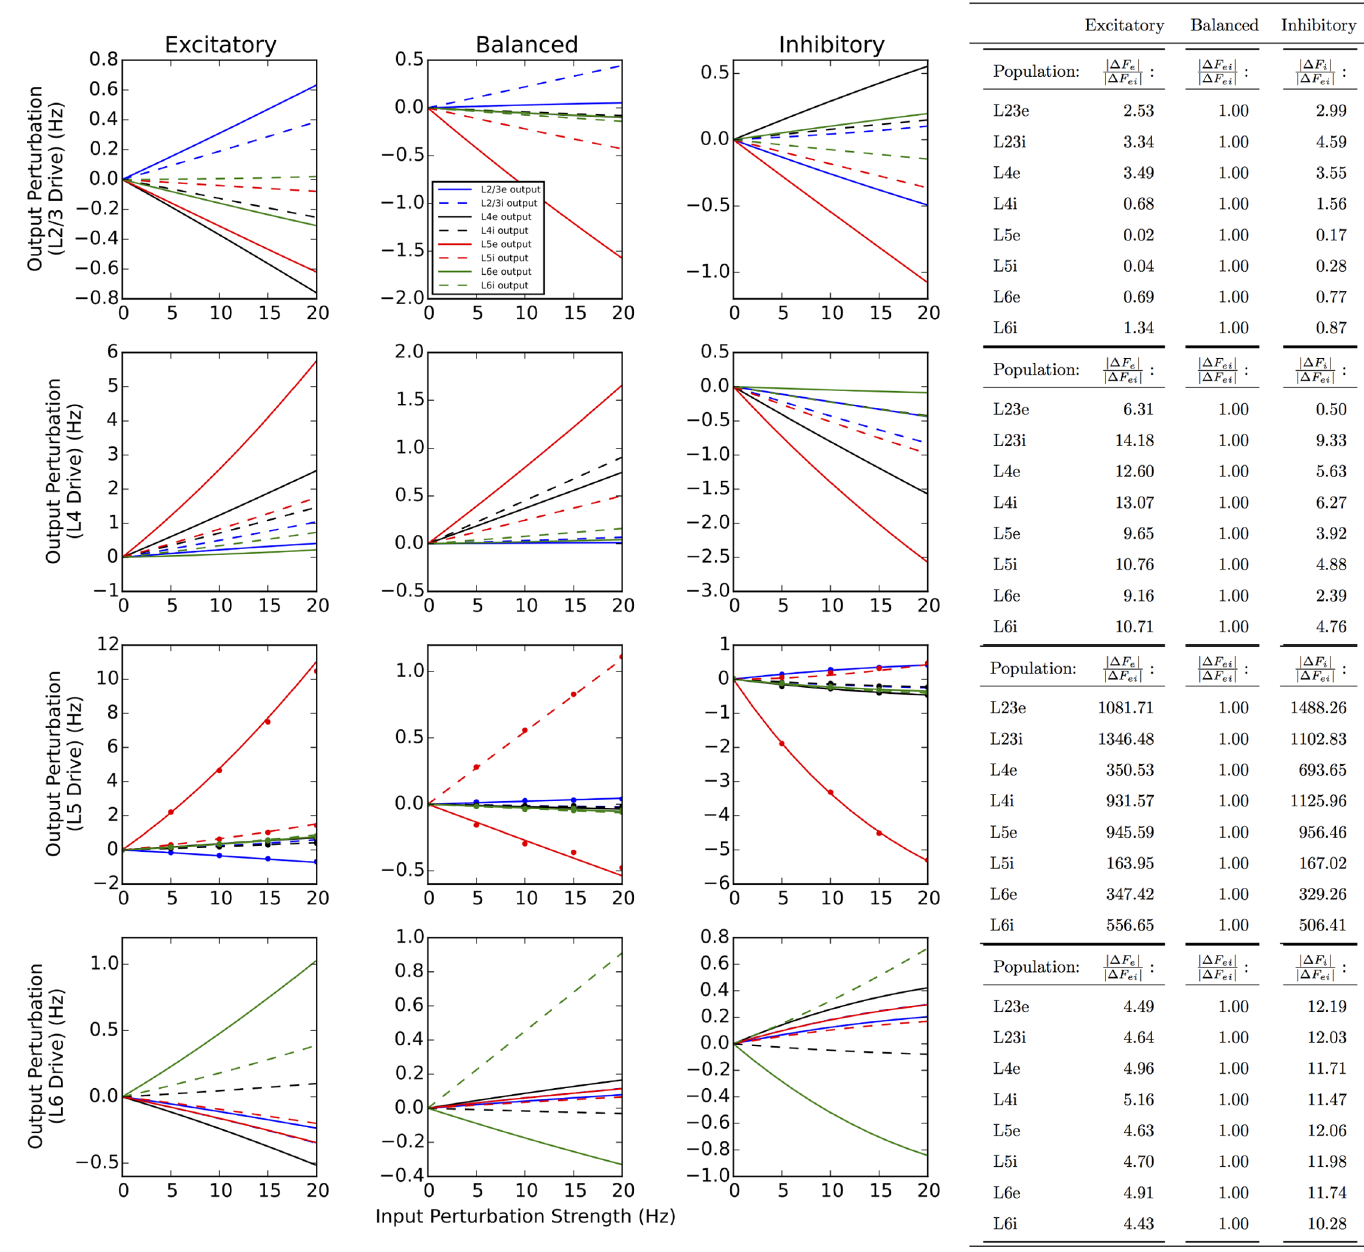
Fig 5. Homogeneity of output perturbations. As the magnitude of the input drive increases, the output perturbation responds either linearly (balanced target specificity) or nonlinearly, demonstrating that the target specificity of the incoming input shapes the linearity of the response. Solid and dashed lines indicate perturbations of excitatory and inhibitory populations, respectively (L2/3, blue; L4, black; L5, red; L6, green). For example, when L5 (i.e. 3rd row) is driven with balanced target specificity (middle column), the perturbations increase proportionally as input strength increases from 0 to 20 Hz. In contrast, when the inhibitory population is selectively driven (right column), the perturbation increases sub-linearly as input strength increases. Also included in the third row (dots) are results from 100 averaged leaky integrate-and-fire simulations (performed in NEST, see Methods), demonstrating that the trends observed in the population density simulations are present in the original system as well. To quantify linearity, the perturbation resulting from a 5 Hz amplitude step input is extrapolated to 10 Hz, and the percentage deviation of this prediction from the true perturbation relative to pre stimulus steady-state is computed. This relative error (See Main Text, Eq 16) is then normalized by the relative error from the balanced case, demonstrating that in general, balanced inputs result in more linear responses. The table on the right summarizes the relative errors for the different